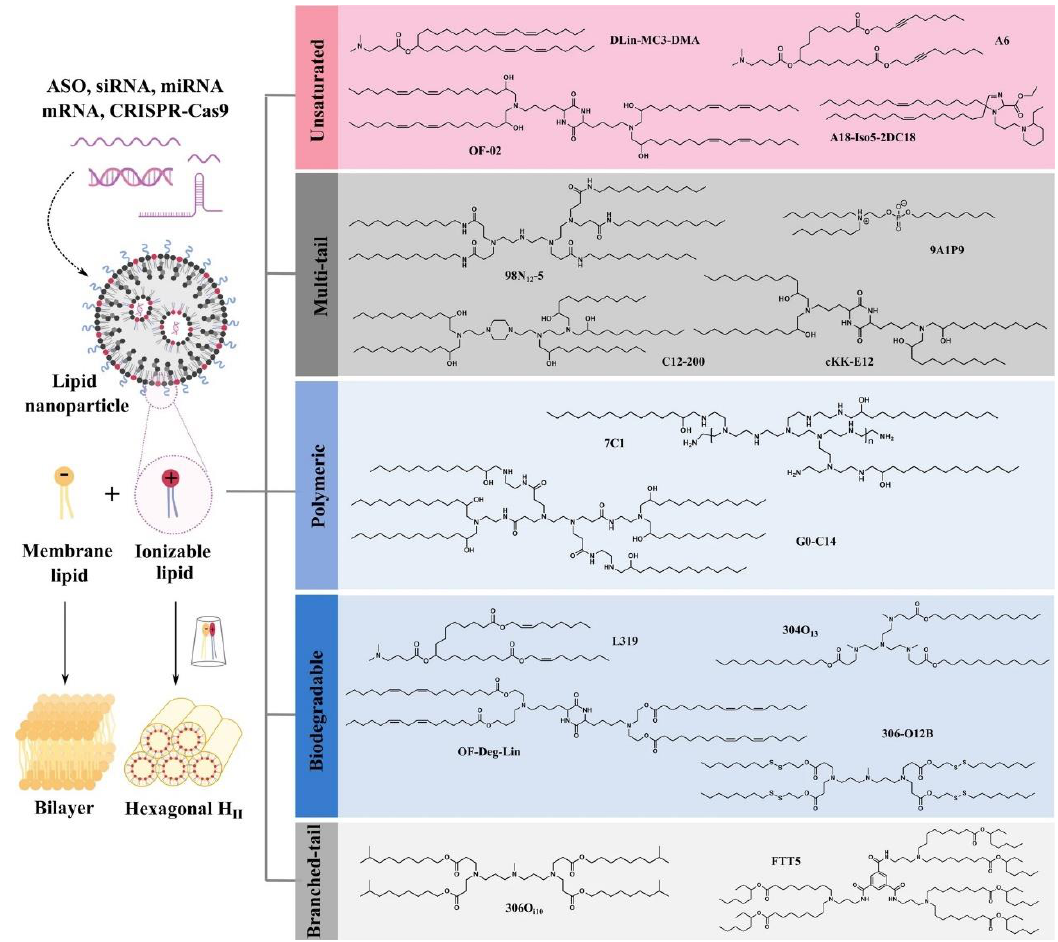
Figure 4. Mechanism of endosome destruction by ionized lipids. Based on their structural charac- teristics, ionized lipids can be classified into five types: unsaturated, multitailed, polymerized, bio- degradable, and branching tails [165].